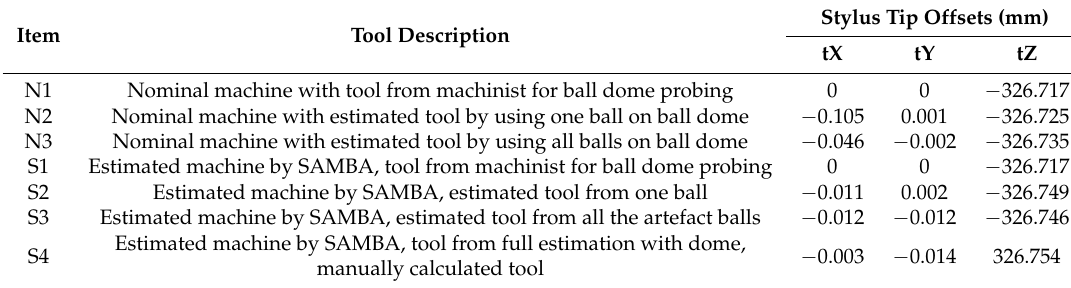
Figure 4. Left : For a nominal machine, the reference frame of the spindle coincides with the B- and C-axis crossing point, which is also the machine foundation frame. For case N1 the tool only has a non-zero z coordinate. Right : The non-nominal machine estimated by the SAMBA method has spindle offsets in x from the B-axis and in y from the C-axis. This right-side diagram also illustrates the cases of an imperfect tool with lateral offsets in x and y. Table 4. Various stylus tip offsets.